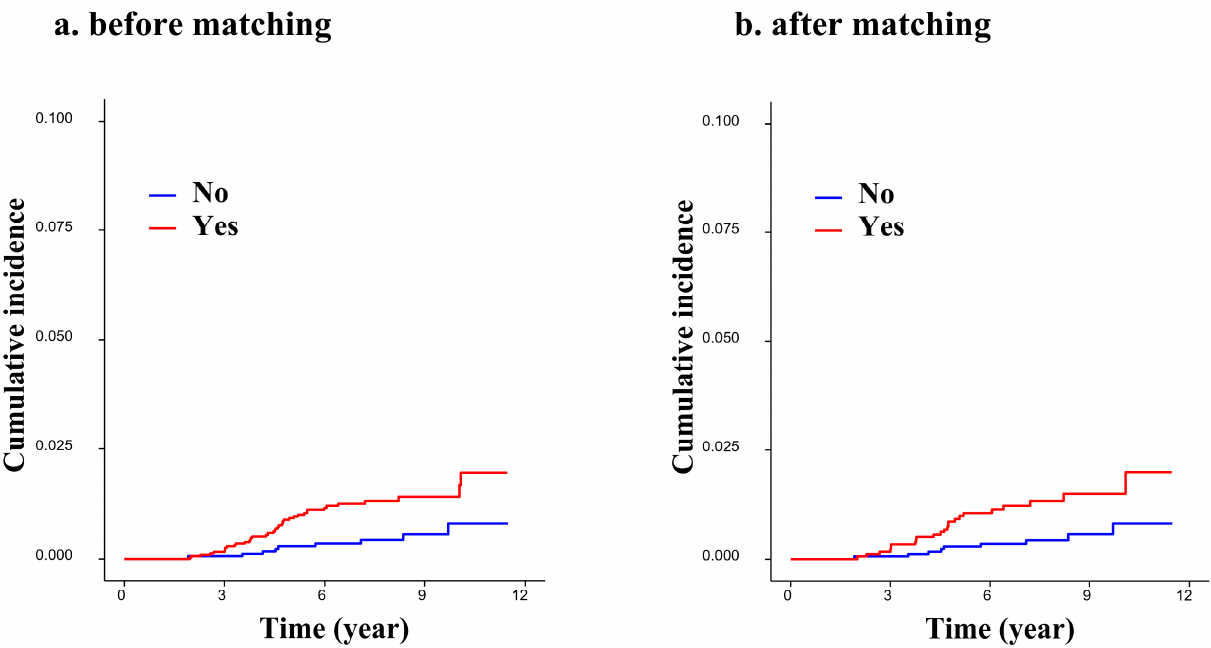
Figure 2. Cumulative incidence of endometrial cancer according to long-term use of tamoxifen: ( a ) before matching, log-rank test, p -value = 0.0036; ( b ) after matching, log-rank test, p -value = 0.004.